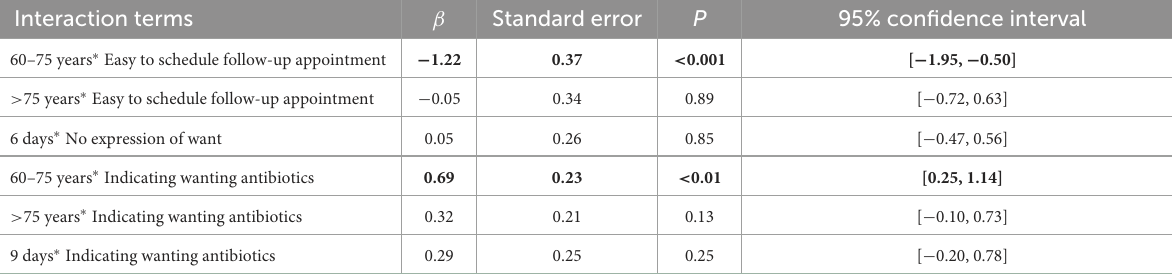
TABLE 5 Interaction effects between clinical and non-clinical factors: results of mixed logit